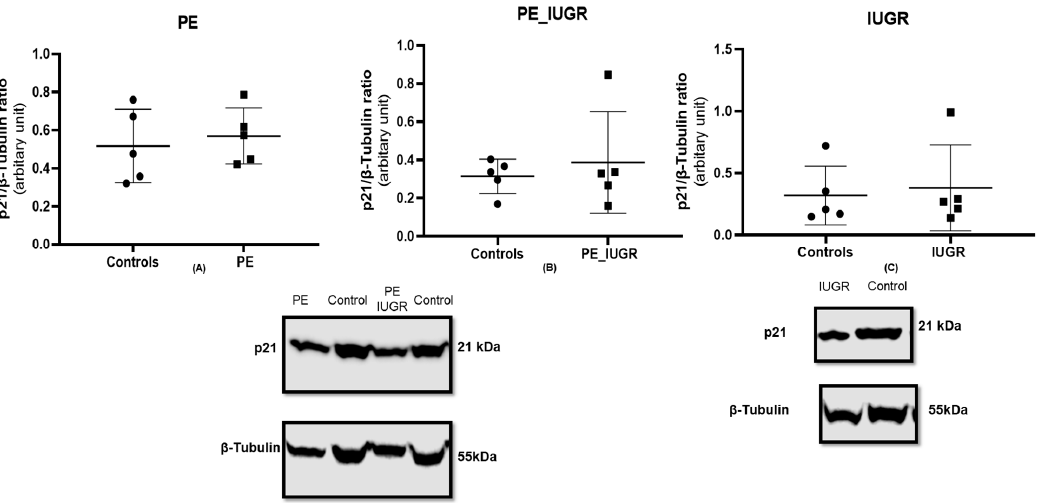
Figure 5. p21 expression in placental tissue using the standard SDS-page gel method; ( A ) pre- eclampsia, n = 5, ( B ) pre-eclampsia associated with IUGR, n = 5, and ( C ) IUGR >10th centile, n = 5. Statistical analysis with Wilcoxon matched-pairs signed rank test with two-tailed test. Protein expression of p21 was normalised to the expression of the housekeeping reference protein B-tubulin. A reduction in Lamin B1 protein expression has been detected in senescent cells and is induced by various triggers including cell replication and oncogene activation. Lamin B1 has roles in DNA replication and cell cycle progression in addition to maintaining nuclear envelope integrity. Expression of Lamin B1 was not significantly different in pre- eclampsia groups (Supplementary Figure S2a, b) or IUGR (Figure S2c), respectively, when compared with controls. We compared absolute mtDNA copy numbers in placental tissue for pre-eclampsia subgroups and IUGR, comparing them to controls (Supplementary Figure S3). Even though all groups showed increases in placental mtDNA copy numbers, both pre-eclampsia subgroups and IUGR failed to reach statistical significance compared with controls.